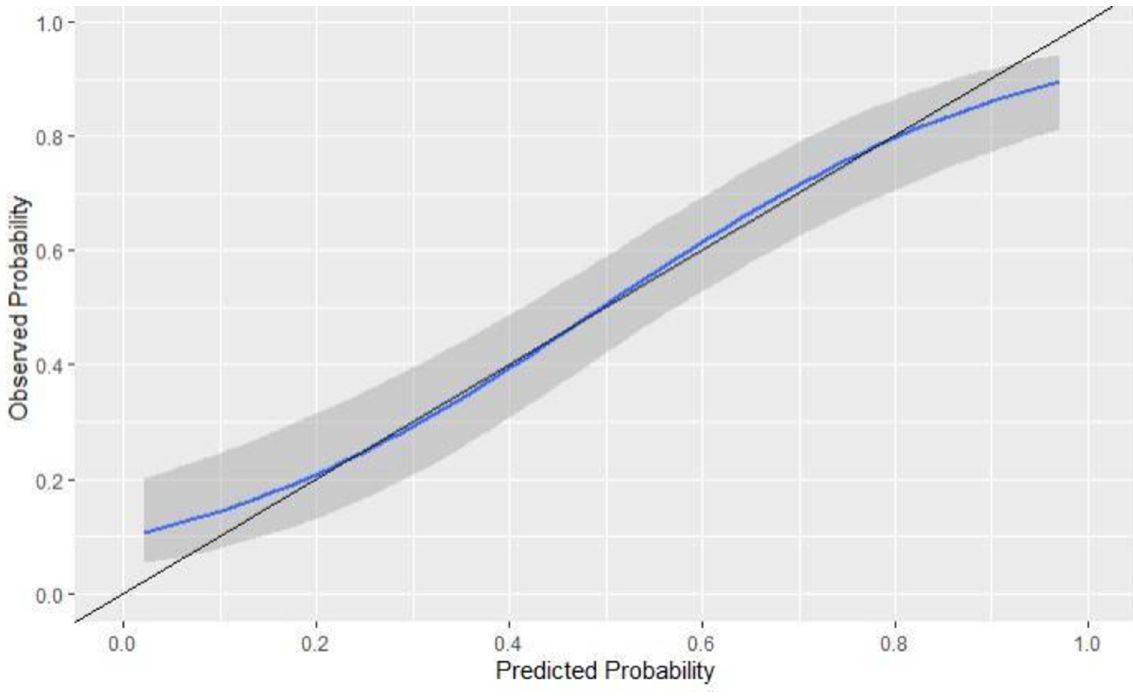
Fig 5. A calibration plot of the 2-year ED model. The solid black line represents an ideal model where the predicted probabilities correspond with the actual probabilities. The gray band represents the standard error of the mean (SEM) while the solid blue line shows the performance of the